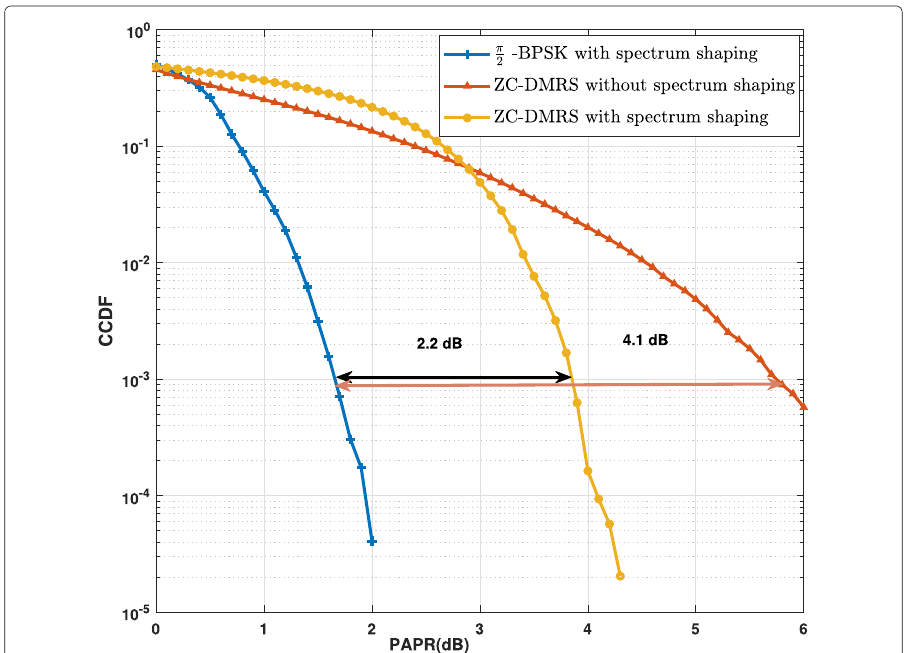
Fig. 14 PAPR of length 96 ZC and π/ 2-BPSK DMRS